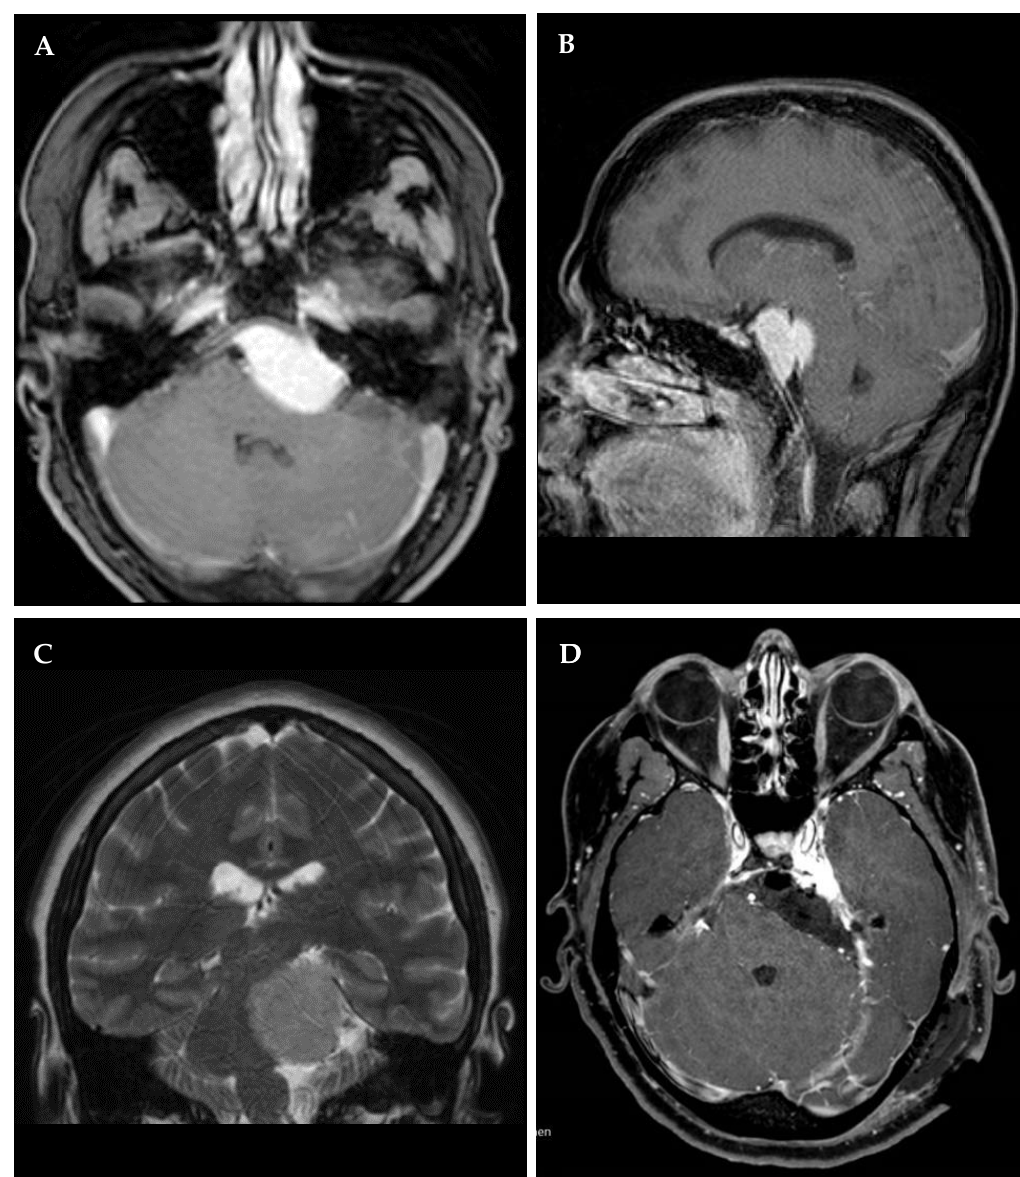
Figure 4. Left petroclival meningioma in a 31-year-old female who presented with trigeminal hypesthesia. Preoperative contrast-enhanced T1 magnetic resonance imaging (MRI) in axial ( A ) and sagittal ( B ) reconstructions as well as coronal T2 ( C ). Postoperative T1 MRI in axial reconstructions ( D ) after Simpson grade IV resection for decompression of the brain stem via a retrosigmoid ap- proach.